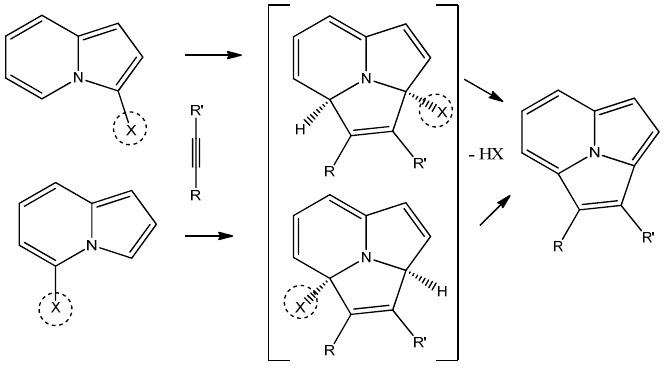
Scheme 14. Cycloaddition of indolizines with 3(5)-leaving groups. Such groups X can be -OR or -OCOR. -SR, -NR 2 or -NR-NR 2 , halogen and some others, Scheme